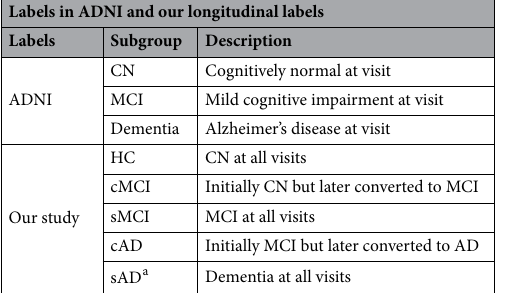
a The sAD subgroup